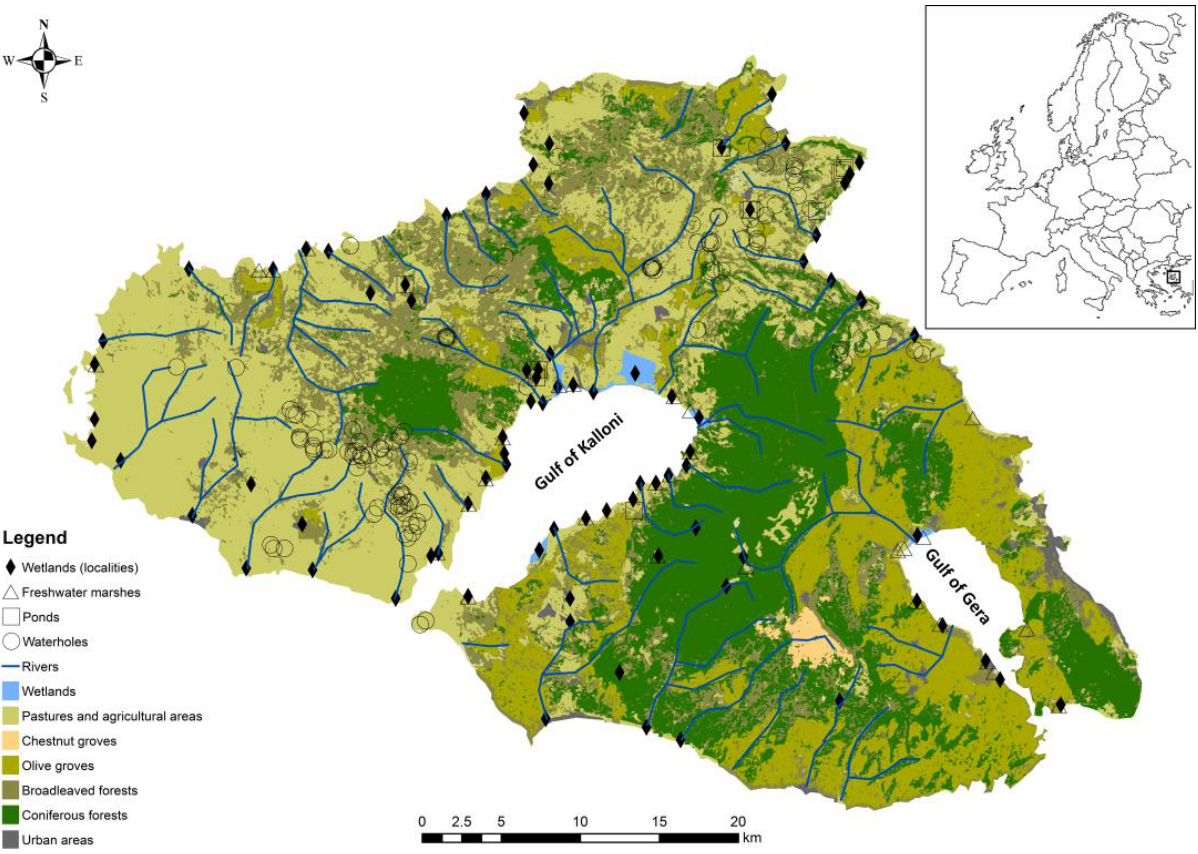
Figure 1. Distribution map of the island of Lesvos showing the main wetlands, freshwater marshes, ponds, and waterholes (giolia), along with its main habitat types.